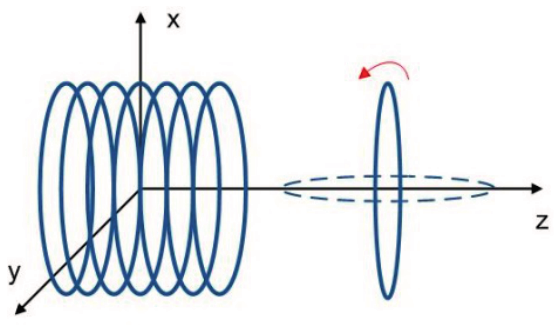
Figure 6. Multi and single wound coils.